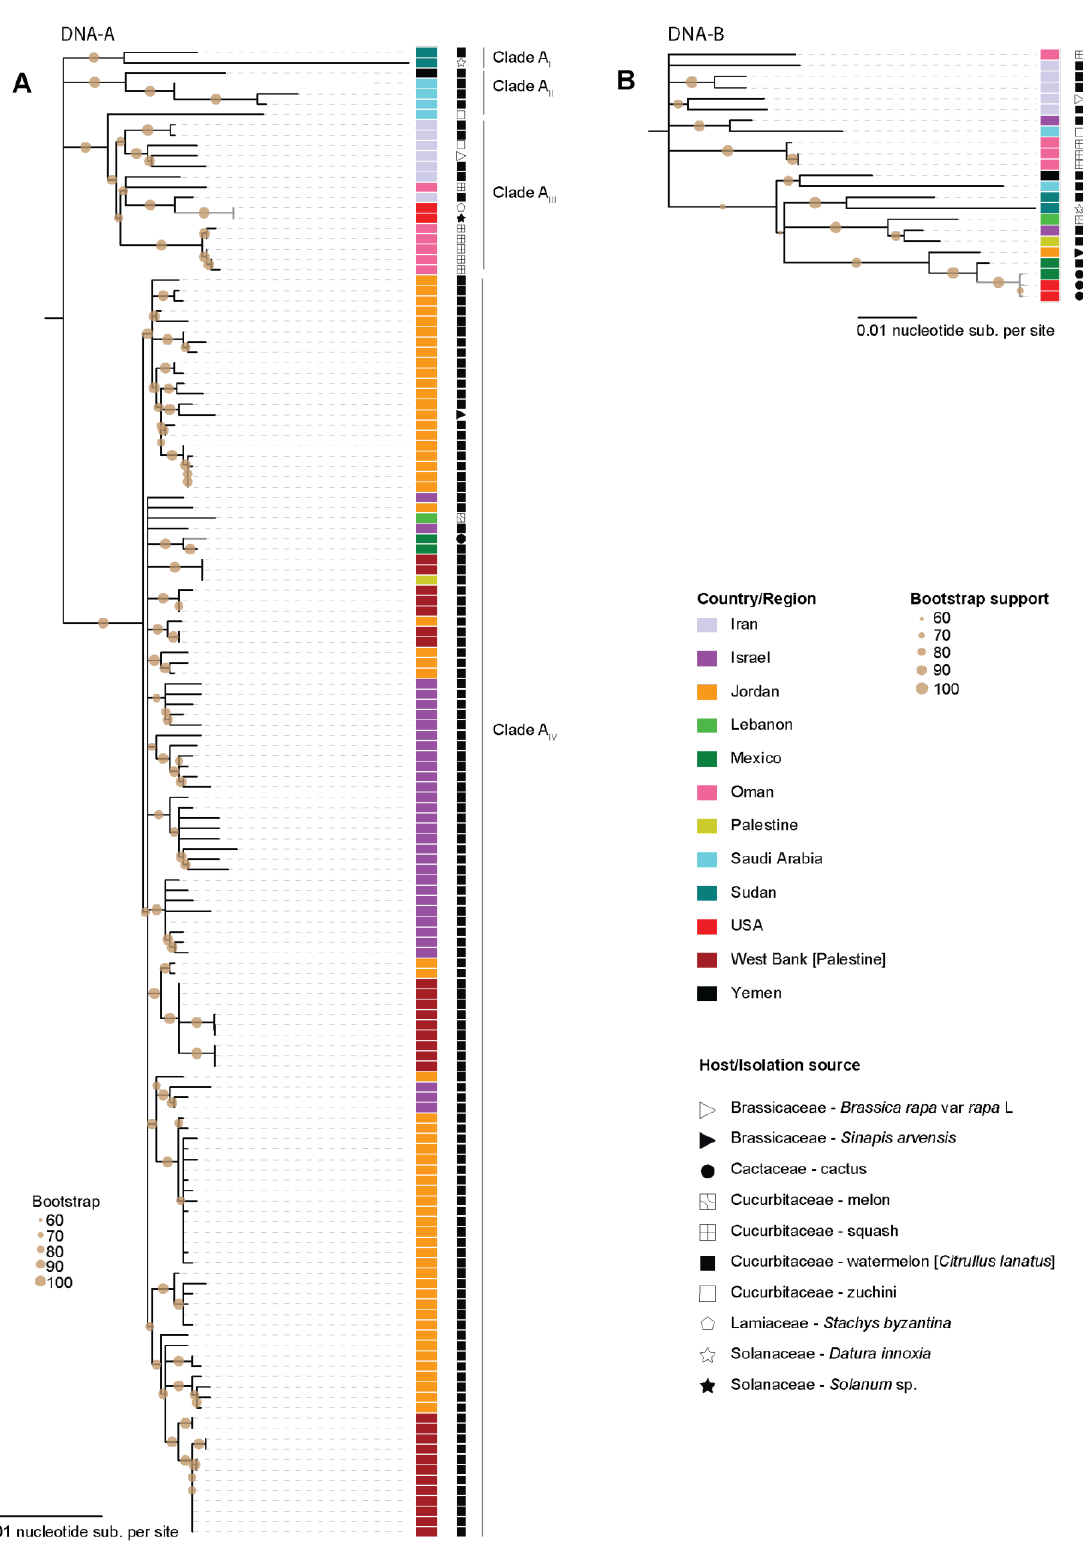
Figure 3. Maximum-Likelihood phylogenetic tree of the WCSV ( A ). DNA-A and ( B ). DNA-B component sequences. The country from which the sequences have been identified are color coded and the host/isolation source is marked by symbols. Clades containing the sequences from this study are colored in grey.